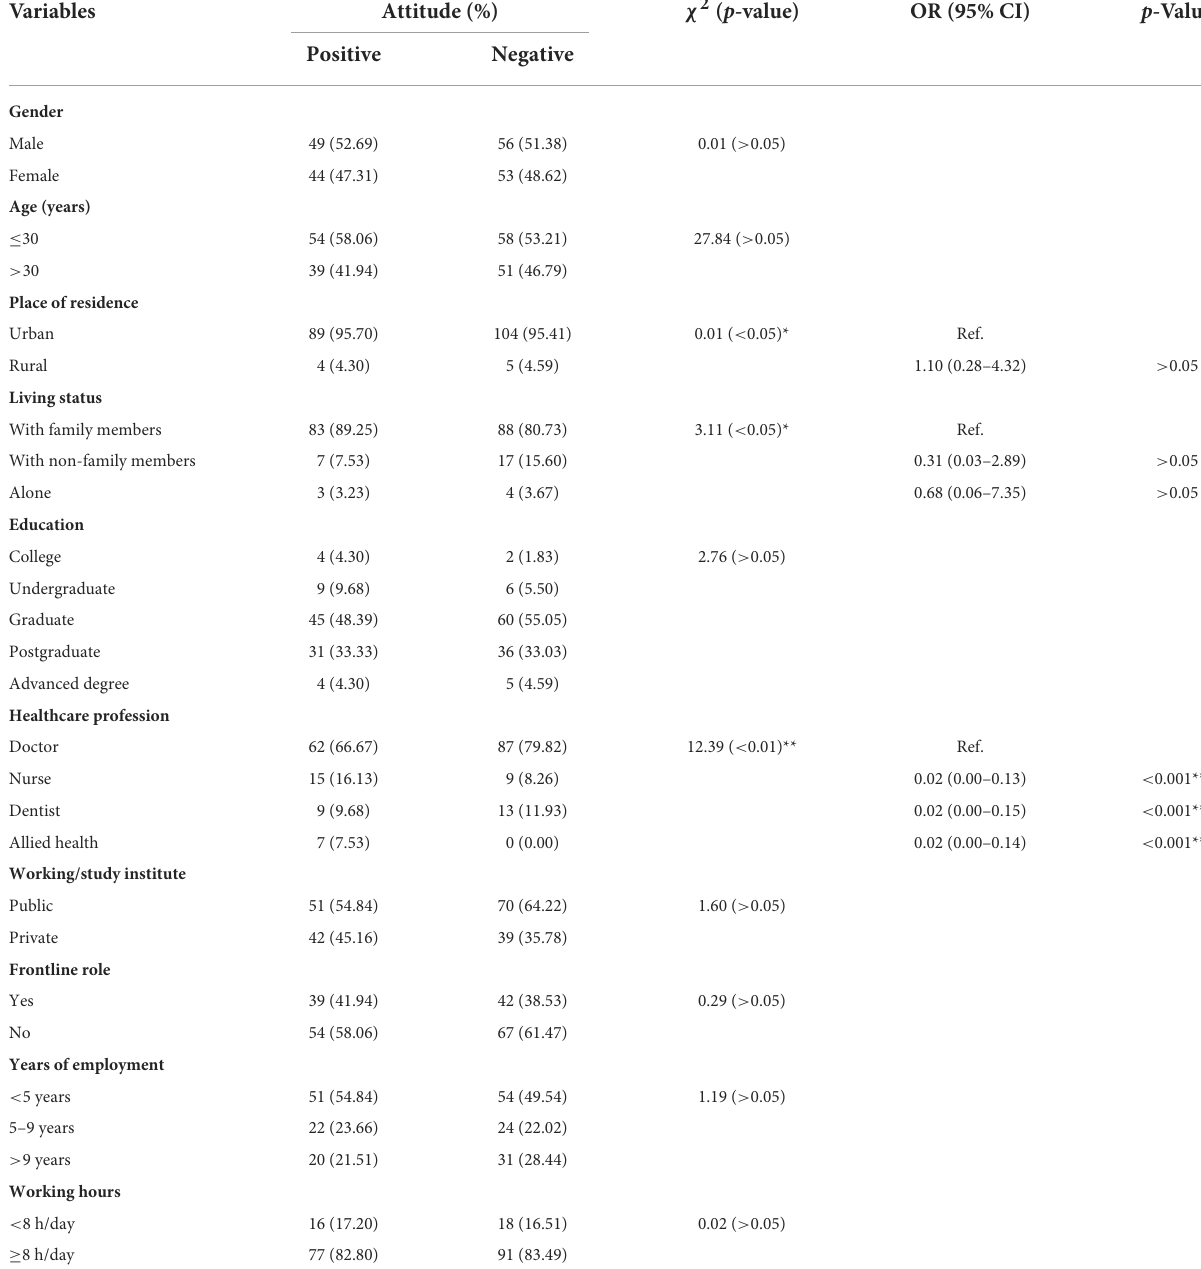
TABLE 6 Factors influencing the attitudes toward COVID-19 among healthcare